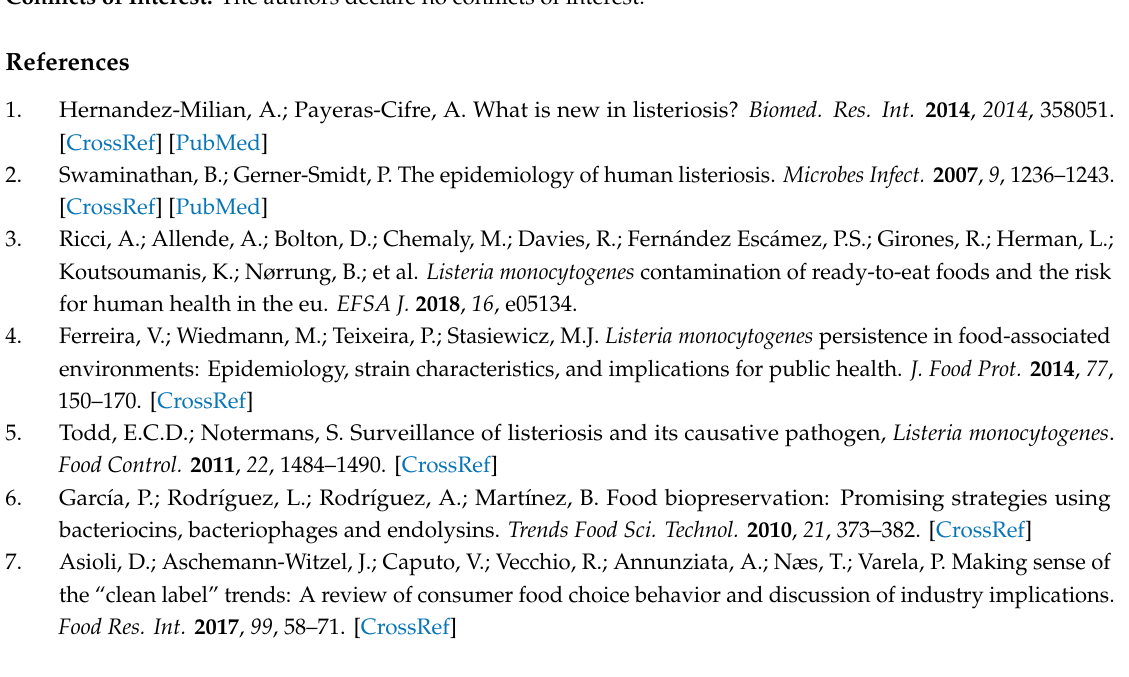
Supplementary Table S1. E ff ect of P100 on ScottA in coleslaw food trial stored at 4 ◦ C over a 10-day period; Supplementary Table S2. E ffi ciency of plaquing of 15 colonies picked from Day 8 and 15 colonies picked from Day 10 of P100 at an MOI of 50 treated coleslaw food trial to check for resistance to P100; Supplementary Table S3. E ffi ciency of plaquing of colonies isolated from phage seeded plates in the rate of resistance to P100 assay; Supplementary Table S4. E ff ect of P100 and Nisaplin ® in combination against ScottA in coleslaw food trial stored at 4 ◦ C over a 10-day period; Supplementary Table S5. E ffi ciency of plaquing and Nisaplin ® sensitivity of colonies picked from Day 10 of combination food trail of Nisaplin ® alone, P100 alone, and P100 and Nisaplin ® in